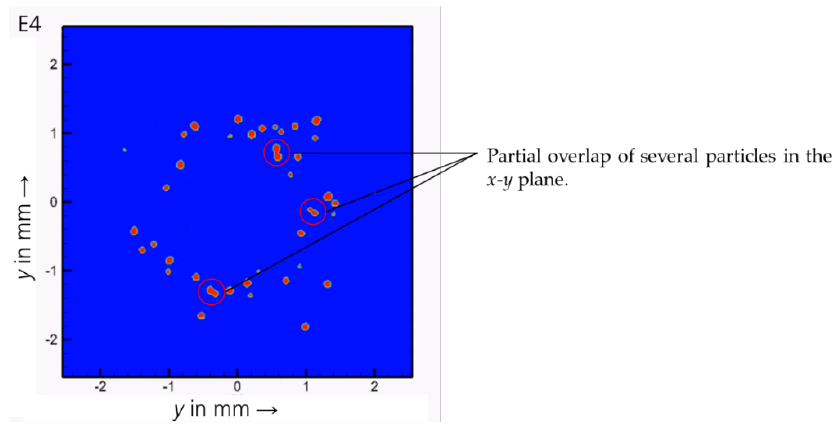
Figure 12. Diagram of the partial overlap in the x-y plane within a single image in level E4. Parameters: grain fraction − 53 + 20 µm, = 5 g/min, V FG = 5 L/min, V SG = 10 L/min [1]. Reprinted with permission from Ref [1]. Copyright 2020, Fraunhofer Verlag.